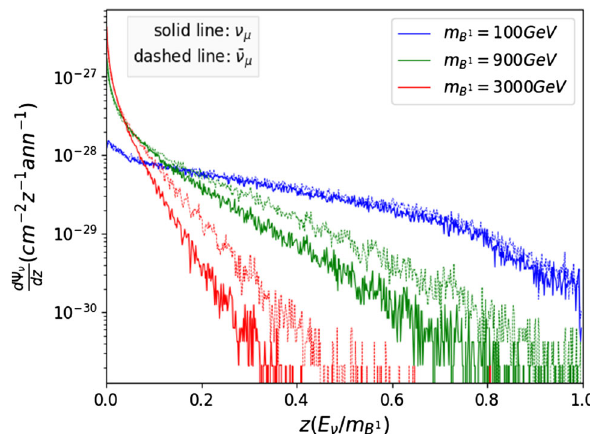
Fig. 1 Predicted energy spectra of muon neutrinos (solid lines) and anti-muon neutrinos (dashed lines) at the detector from B 1 annihila- tions, for three different values of m B 1 . An extra peak at the end of the spectra produced by neutrinos that escape the Sun without interacting has been omitted from the plot for the sake of legibility, but it is consid- ered in the calculations. Note the normalization in relative energy